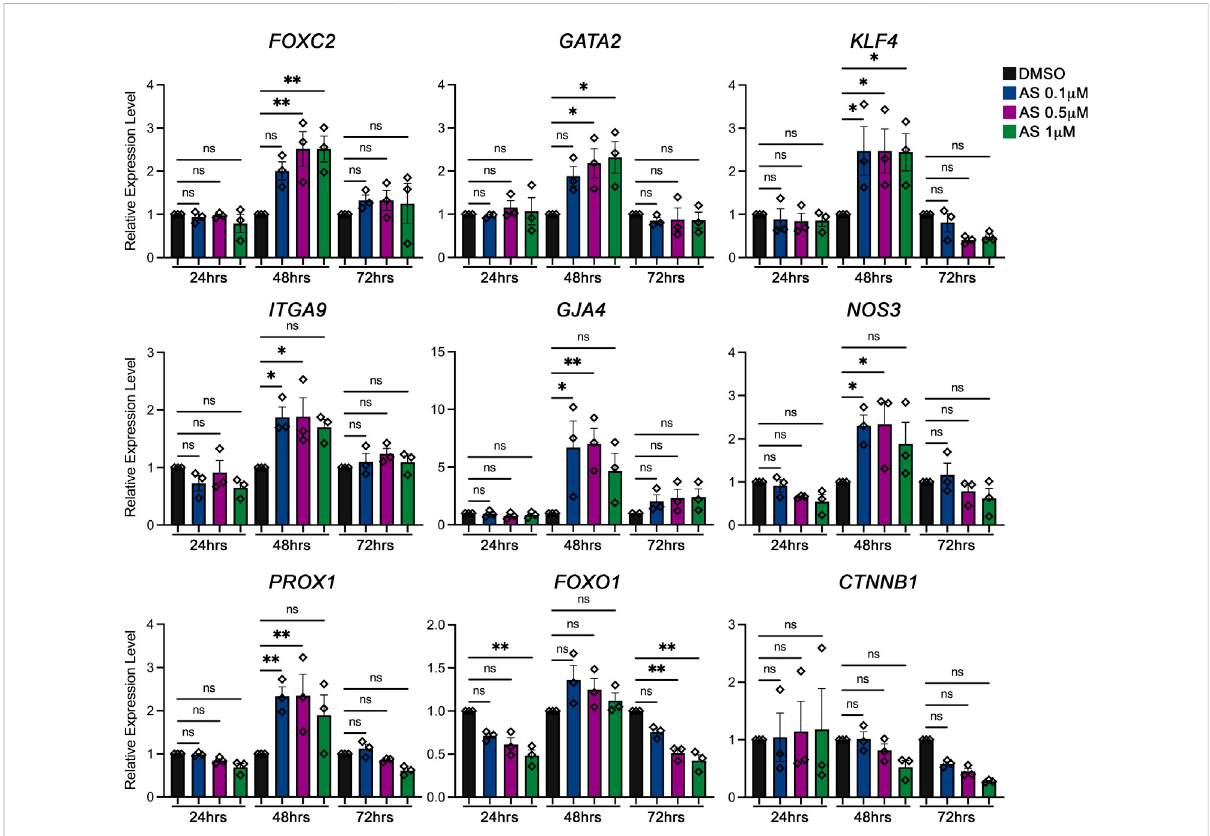
FIGURE 1 AS1842856(AS)hasatime-andconcentration-dependenteffectonvalve-forminggeneexpression.Humandermallymphaticendothelialcells (hdLECs) were cultured under static conditions and treated for the indicated time (24 h, 48 h, and 72 h) and concentrations: DMSO 1 µM (black), AS 0.1 µM (blue), AS 0.5 µM (purple), and AS 1 µM (green). Afterward, mRNA was extracted and reverse transcribed. The expression levels of indicated genes were quanti fi ed by qRT-PCR analysis. All values are mean ± SEM. n = 3 experiment repeats; ns = not signi fi cant; * p ≤ 0.05, ** p ≤